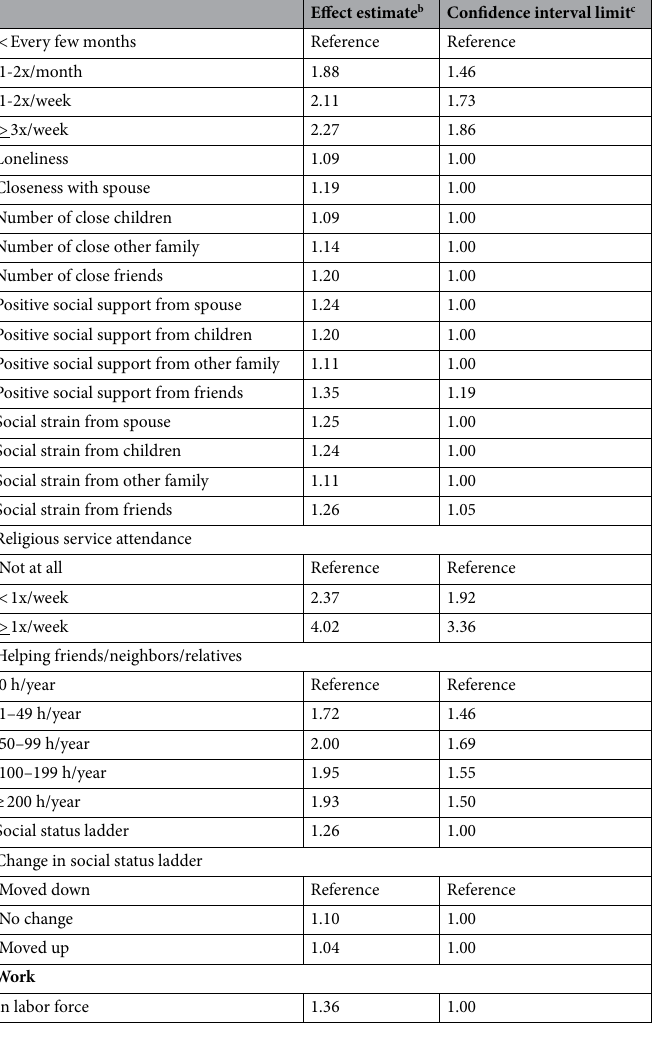
Table 3. Robustness to unmeasured confounding (E-values) for the associations between candidate antecedents and subsequent volunteering (N = 13,771) a . a See VanderWeele and Ding 52 for the formula for calculating E-values. b The E-values for effect estimates are the minimum strength of association on the risk ratio scale that an unmeasured confounder would need to have with both the exposure and the outcome to fully explain away the observed association between the exposure and outcome, conditional on the measured covariates. c The E-values for the limit of the 95% confidence interval (CI) closest to the null denote the minimum strength of association on the risk ratio scale that an unmeasured confounder would need to have with both the exposure and the outcome to shift the confidence interval to include the null value, conditional on the measured